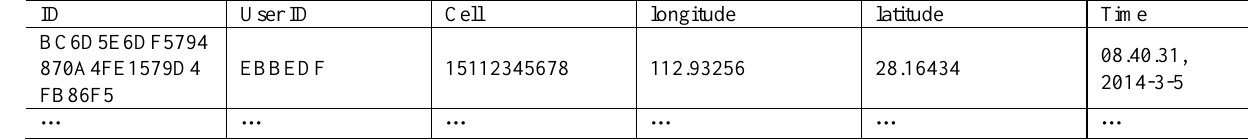
Table 4 Real-time location of the volunteers in